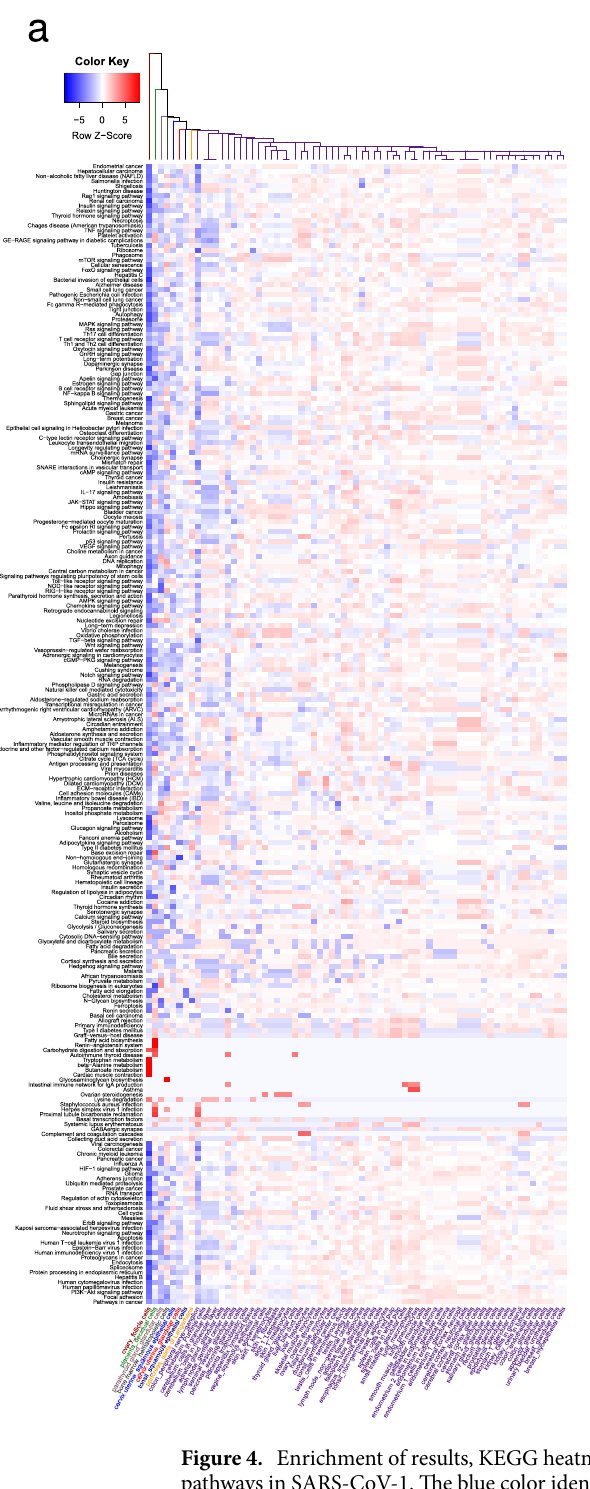
disarranges have been found. Our results indicate a gradient of molecular interactions, and therefore a possible explanation of susceptibility to infection. An hypothesis of a gradient of susceptibility to infection is supported by the availability of entry proteins, the concordance of connectivity, and previous autopsy and clinical reports.